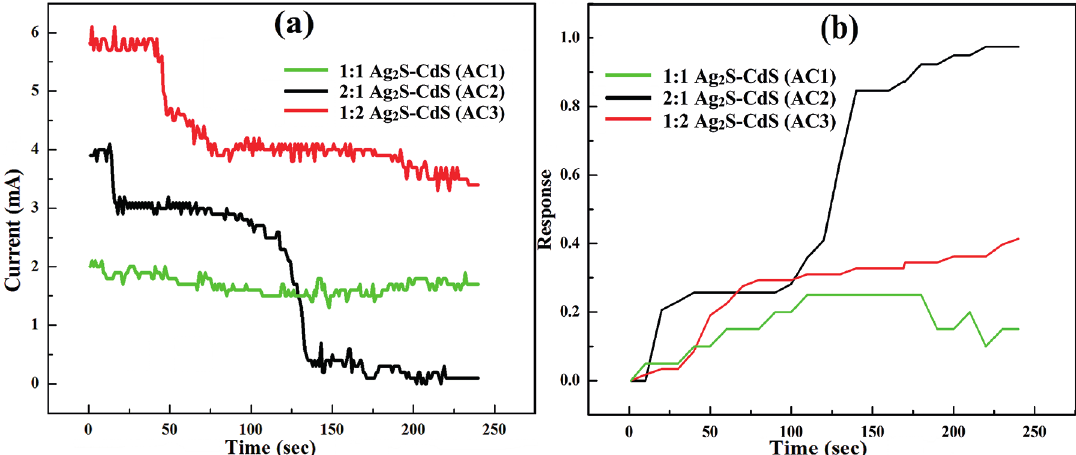
S-CdS) hybrid nanocomposites showing (a) Drop in current and (b) change in response factor with respect to time. Figure 9. Various PPy/(Ag 2 Table 1. Response factor values for sensing different concentration of NH PPy nanocomposites Response factor value towards different concentration of NH Ratio and